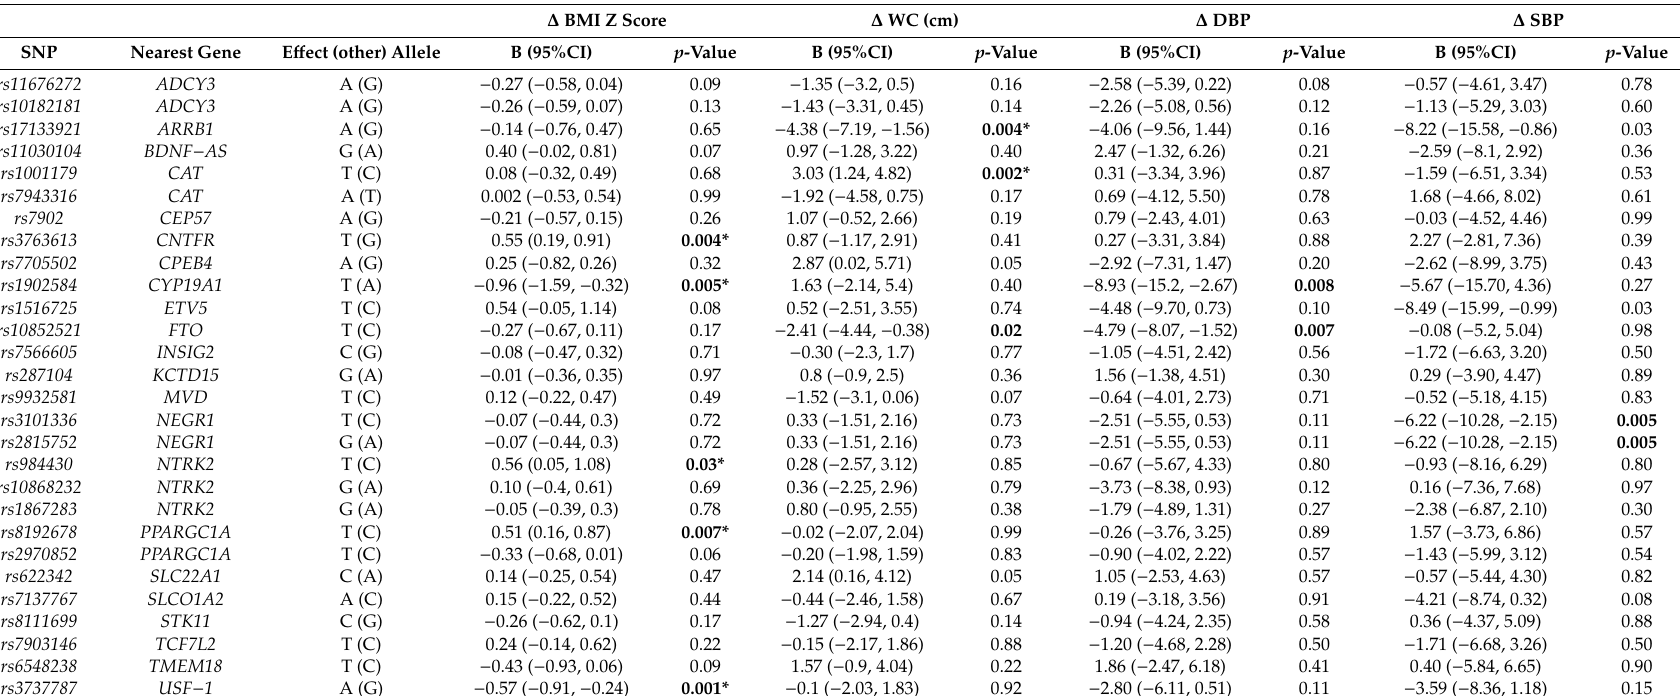
Table 2. Summary of association data for the 28 selected common variants in anthropometry and blood pressure